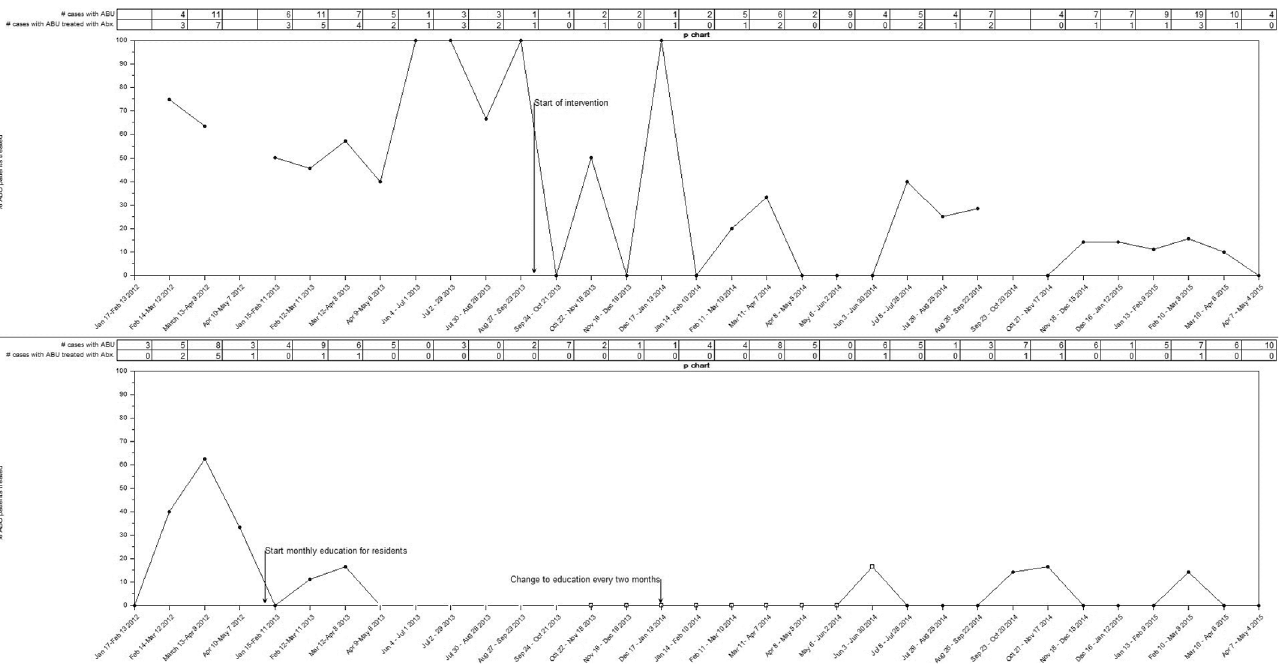
Fig 3. Time series data showing the monthly proportion of patients with ABU unnecessarily treated (p-chart). (A) Percentage of ABU cases treated inappropriately over time on the intervention CTU. (B) Percentage of ABU treated inappropriately on the control CTU. Total number of cases per month shown, with the associated number that were treated inappropriately during and after the intervention period.